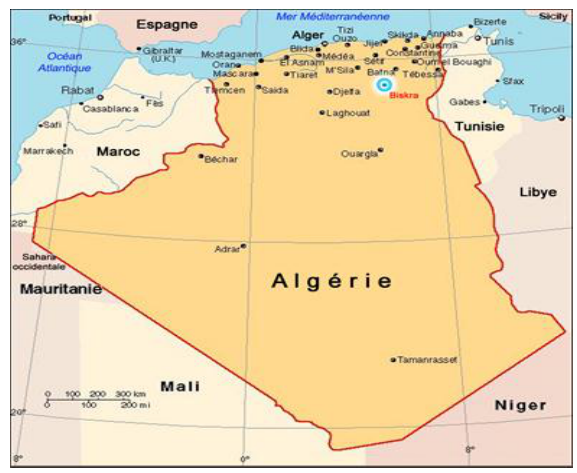
Figure 1: Geographic situation of Biskra [1].